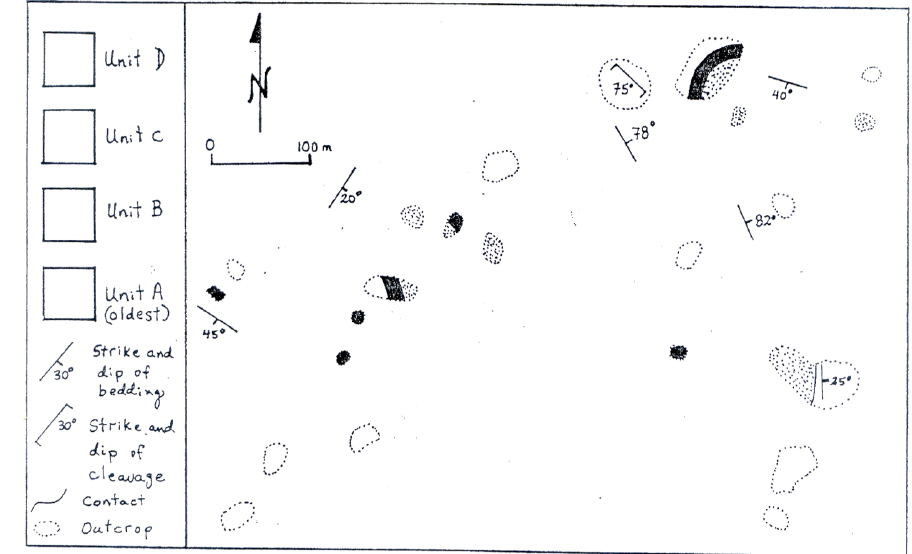
Figure 5. Lab assignment question where students were asked to complete the geological map and draw a cross section (adapted from Archibald,